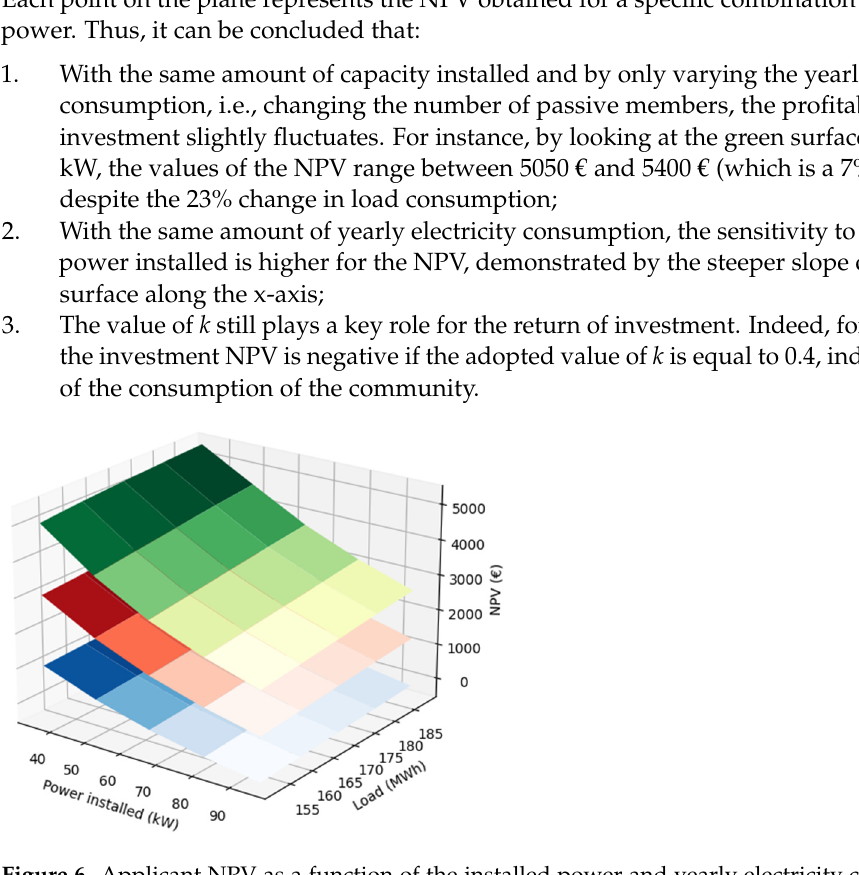
Figure 6. Applicant NPV as a function of the installed power and yearly electricity consumption. Blue surface obtained for values of k = 0.4, red surface for k = 0.6 and green surface for k = 0.8 .